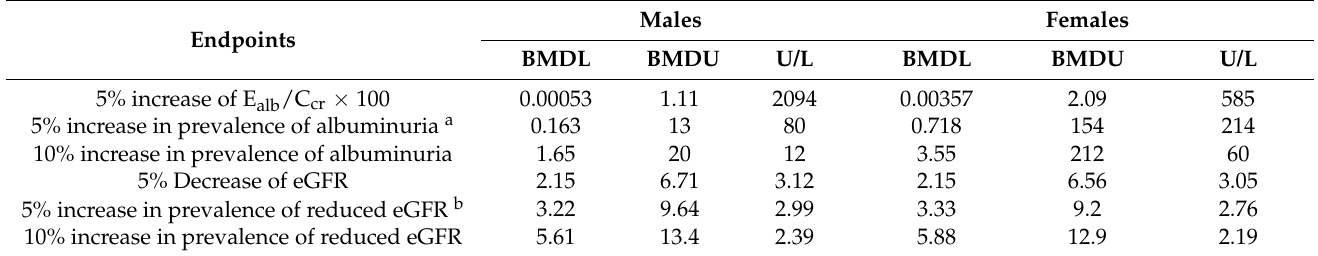
Table 6. BMDL and BMDU values of E Cd /C cr computed from albumin excretion and eGFR